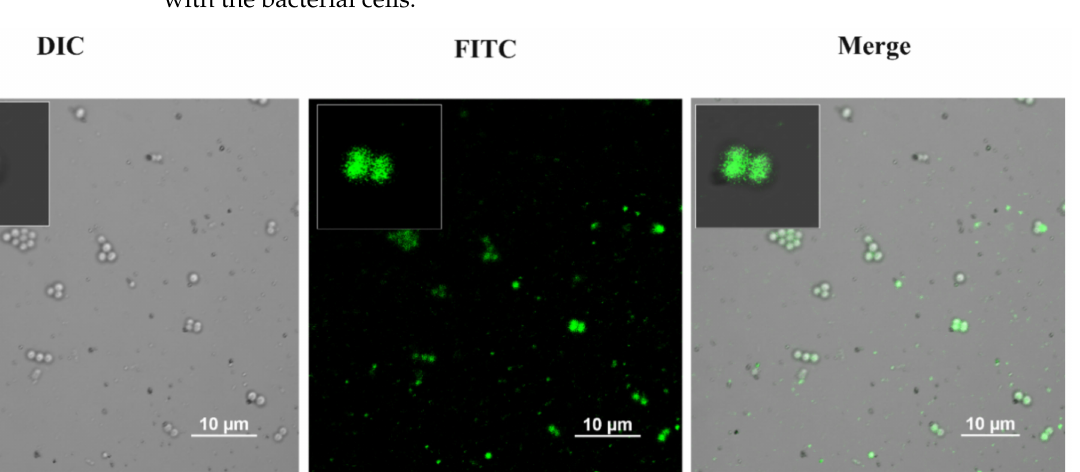
Figure 10. CLSM images of S. aureus cells after 8 h incubation with FITC-rGO-S/Se NPs (100 µ g/mL). Scale bar = 10 µ